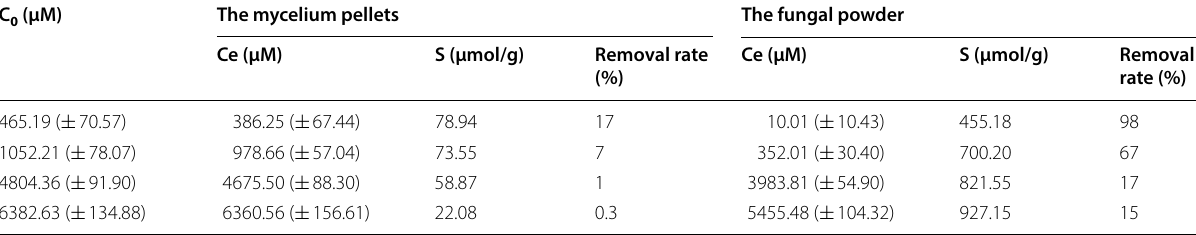
Table 3 Adsorption of Y 3 + by the mycilium pellets and the dry fungal powder C 0 (µM) The mycelium